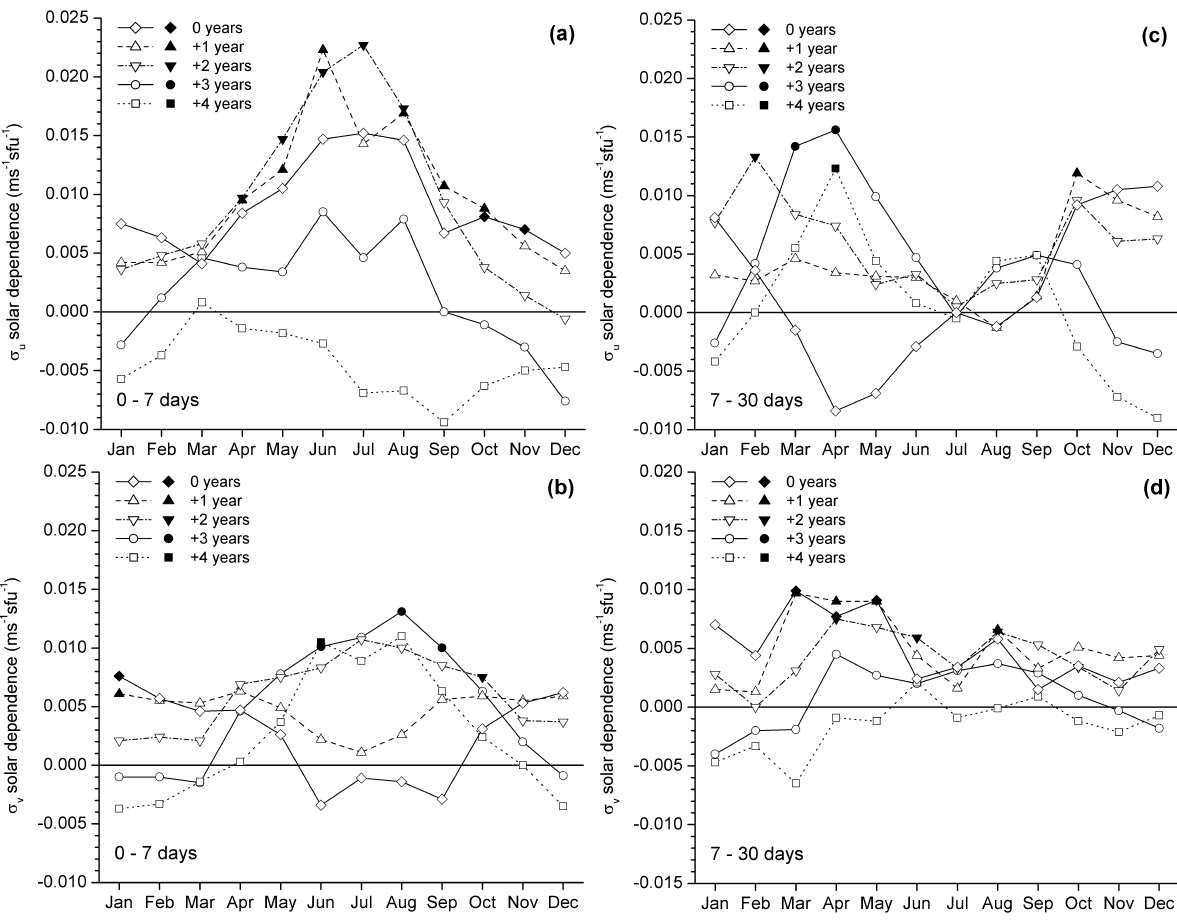
Fig. 7. Solar cycle dependence (coefficients B from Eq. 2) for the standard deviations of the zonal (upper panels) and meridional (lower panels) daily mean wind filtered in the 2–7 (left panels) and 7–30 (right panels) period intervals. The F10.7 time series has been shifted with respect to the winds by 0–4 years, i.e. a shift of one year means that the 1990 F10.7 value is compared with the winds in 1991 etc. Solid symbols denote statistically significant correlation according to a